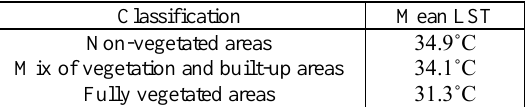
Table 3. The mean LST within different land cover